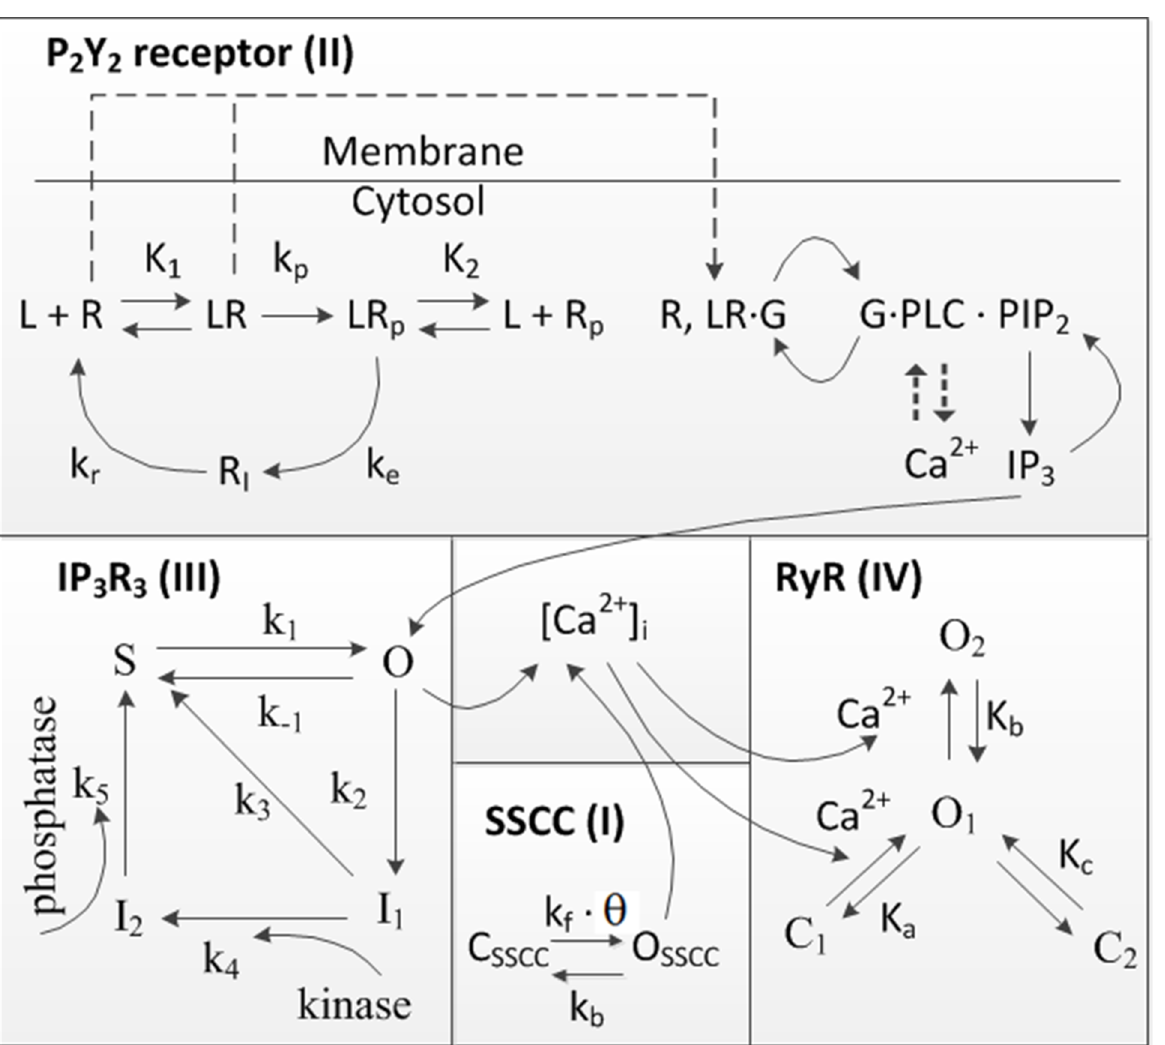
Fig 3. Kinetic diagram. Kinetics of the model component I (SSCC) were combined with the kinetics of model components II-IV from the original models of the P 2 Y 2 receptor[21], IP 3 R 3 [22], and